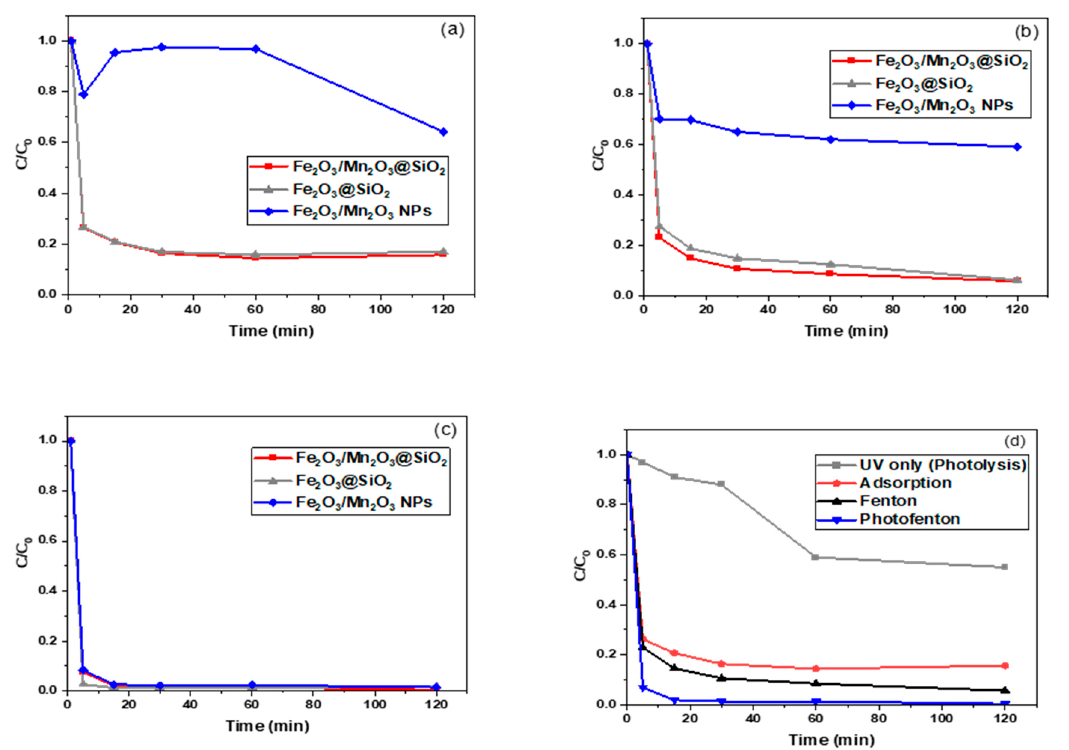
Figure 7. Degradation of rhodamine B (RhB) with Fe 2 O 3 /Mn 2 O 3 nanoparticles (FM-NPs), Fe 2 O 3 /Mn 2 O 3 @SiO 2 (FMS) under different conditions; ( a ) Only adsorption (without UV + H 2 O 2 ), ( b ) Fenton reaction with H 2 O 2 (without UV), ( c ) Photo-Fenton reaction with UV + H 2 O 2 (reaction conditions: catalyst dose = 1 g/L, initial concentration of RhB = 10 mg/L, initial pH = 7), and ( d ) comparison of degradation performance with FMS under different reaction conditions.